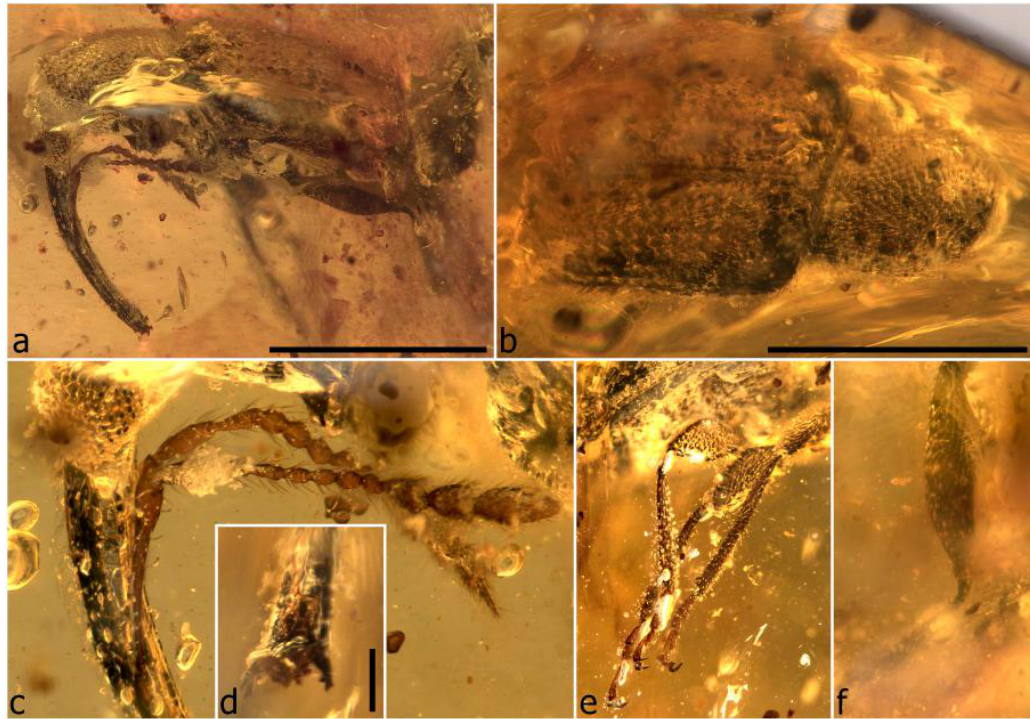
Figure 73. Euryepomus lophomerus sp. n., holotype. Habitus, left lateral ( a ); habitus, dorsal ( b ); eyes and antennae, left lateral ( c ); apex of rostrum and mandibles, apical ( d ); legs ( e ); left hindleg ( f ). Scale bars: 1.0 mm (a,b); 0.1 mm (d).